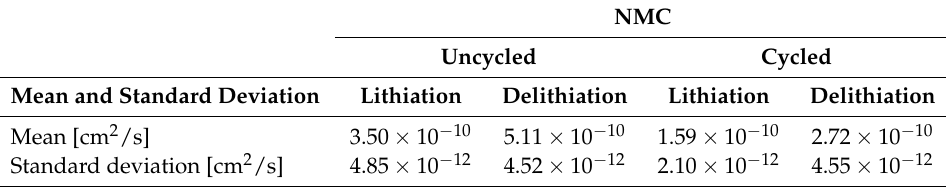
Table 5. Mean and standard deviation of Li + diffusion in NMC uncycled and cycled